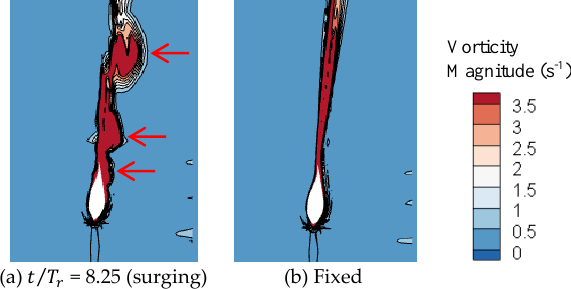
Fig. 9. Contour plots of vorticity magnitude at r/R = 0.8 for surging (a) and fixed (b) turbines at 𝑡 𝑇 𝑟 ⁄ = 8.25, where 𝑈 𝑎𝑝 ≈ 𝑈 ∞ . Comparison of the axial and tangential relative velocities between the surging turbine at 𝑡 𝑇 𝑟 ⁄ = 8.25 ( 𝑈 𝑎𝑝 ≈ 𝑈 ∞ ) and the fixed turbine case are presented in Fig. 8 for a blade cross-section at 𝑟 𝑅⁄ = 0.8, as this is the location at which the blade forces see the most significant change. The streamlines of the resultant velocity relative to the blade, 𝑊 , are superimposed onto the contour plots.